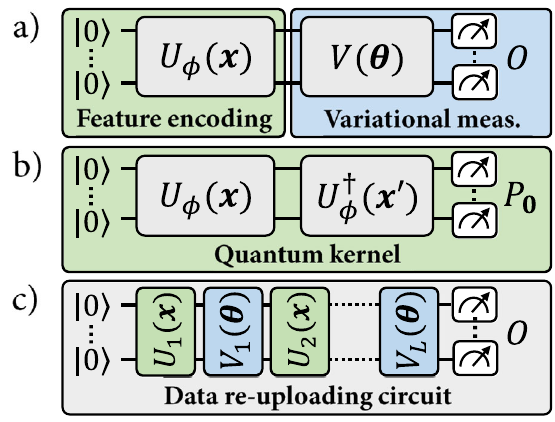
Fig.1|Thequantummachinelearningmodelsstudiedinthiswork.a Anexplicit quantum model, where the label of a data point x is speci fi ed by the expectation value of a variational measurement on its associated quantum feature state ρ ( x ). b The quantum kernel associated with these quantum feature states. The expec- tationvalueoftheprojection P 0 = ∣ 0 i 0 h ∣ correspondstotheinnerproductbetween ρ ( x ) and ρ ð x 0 Þ . An implicit quantum model is de fi ned by a linear combination of such inner products, for x an input point and x 0 training data points. c A data